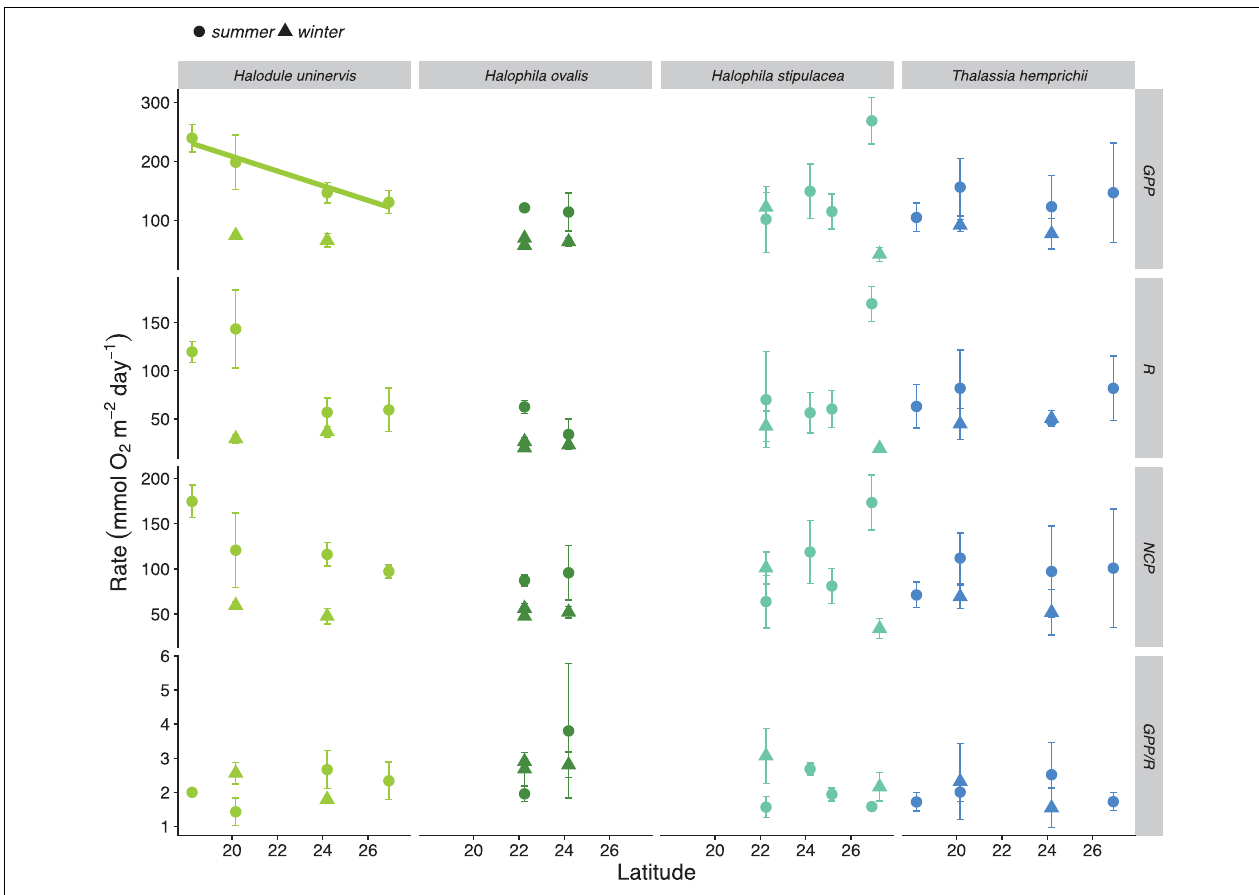
FIGURE 4 | Metabolic rates of seagrass meadows along a latitudinal gradient in the Red Sea. Gross primary production (GPP), respiration (R), and net community production (NCP) are presented in mmol of O 2 m − 2 d − 1 . Colors indicate the dominant seagrass species of the meadows ( Halodule uninervis in light green, Halophila ovalis in dark green, Halophila stipulacea in light blue, and Thalassia hemprichii in indigo blue). Solid dots and triangles indicate the mean ± SD per location in the summer and winter, respectively. Significant relationships are indicated with a solid line. Statistical results provided on Supplementary Table S4